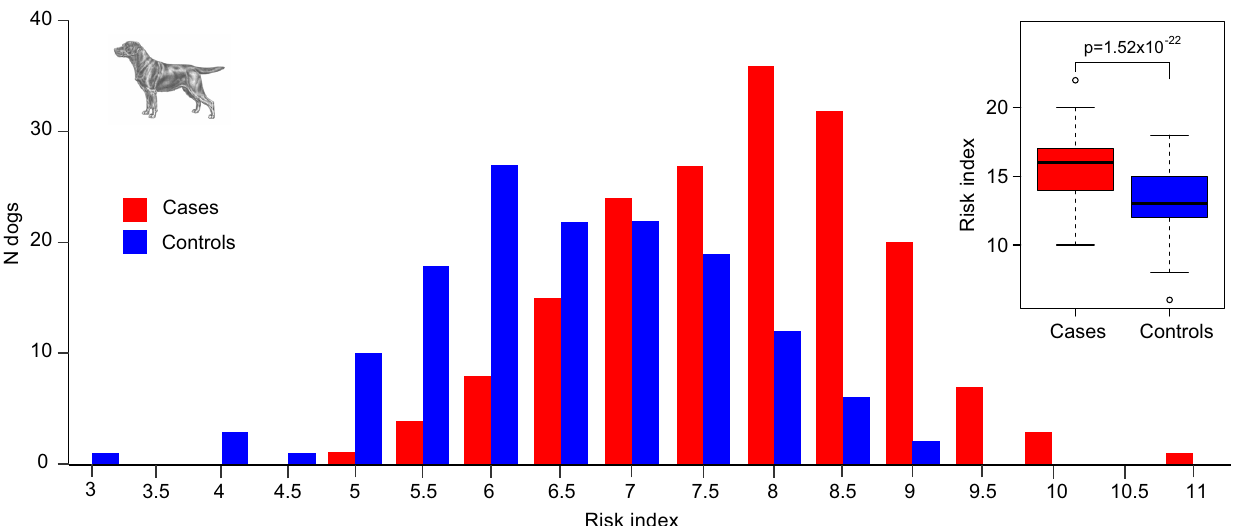
Fig. 2 Canine AD risk index in Labrador retrievers. In LR, the risk genotypes (no risk alleles = 0, one risk allele = 0.5, and two risk alleles = 1 per locus) at the top effect variant for each of the 11 AD-associated loci were combined into a risk index. The distributions of risk indexes were shifted with higher values in cases compared to controls and the mean risk index was signi fi cantly higher in cases (mean = 15.6) compared to controls (mean = 13.1; two-sided t -test p = 1.52 × 10 − 22 , t-statistic = 10.6, n = 321 dogs). The difference is also visualized with boxplots, red (cases) and blue (controls), indicating median, fi rst and third quartiles, and range of whiskers de fi ned by max 1.5 of box length (Supplementary Data